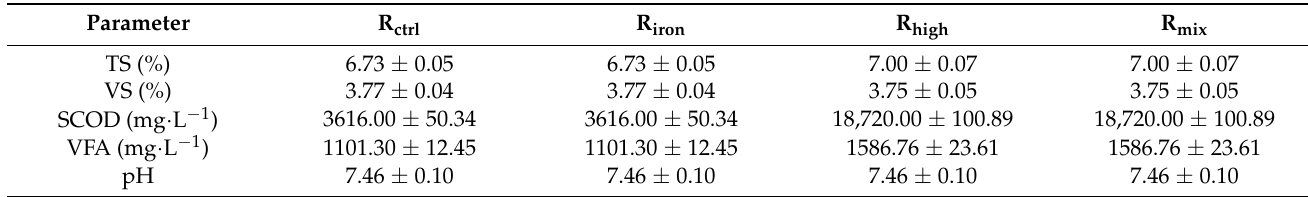
Table 1. Physicochemical properties of sludge before anaerobic digestion.